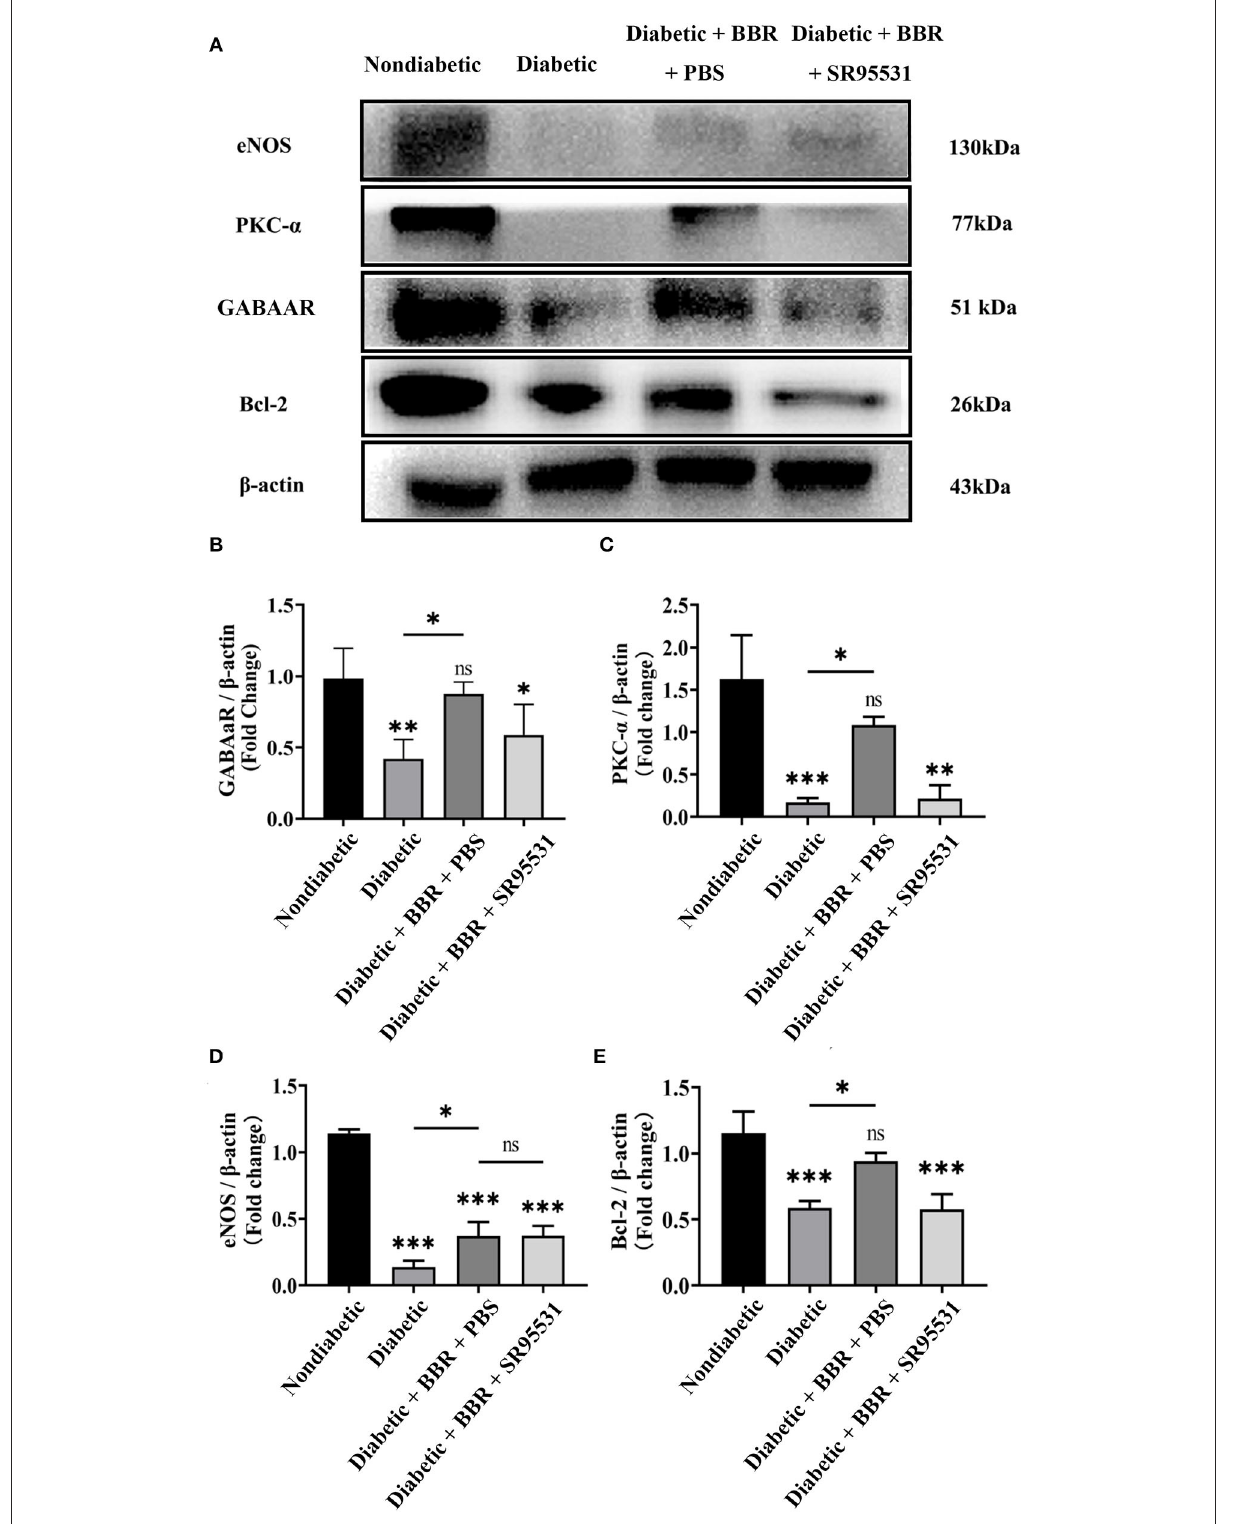
FIGURE9 Berberine inhibits RGC apoptosis through the GABAAR/PKC- α pathway. (A) Representative Western blots of GABAAR, eNOS, PKC- α , Bcl-2, and β -actin protein expression in different groups. (B–E) Statistical analysis of the fold change of GABAAR, eNOS, PKC- α , and Bcl-2 protein expression relative to β -actin. (ns, no significant difference; * P < 0.05, ** P < 0.01 and *** P < 0.001 vs. the non-diabetic group; one-way analysis of